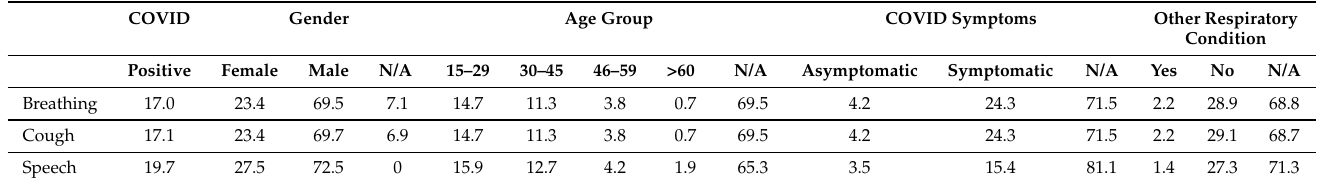
Table 1. The percentages of recordings submitted with various confounding factors, including gender, age group, COVID symptoms, and other respiratory